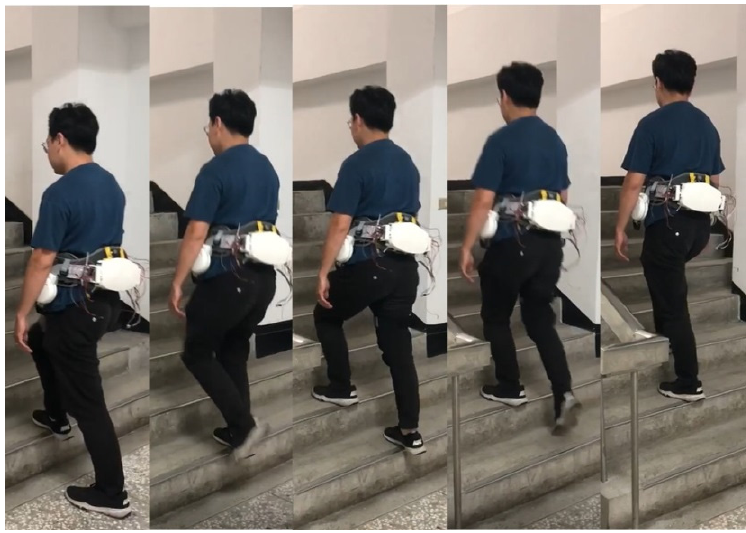
Figure 17. Ascending experiment for gait rehabilitation with robotic hip exoskeleton.